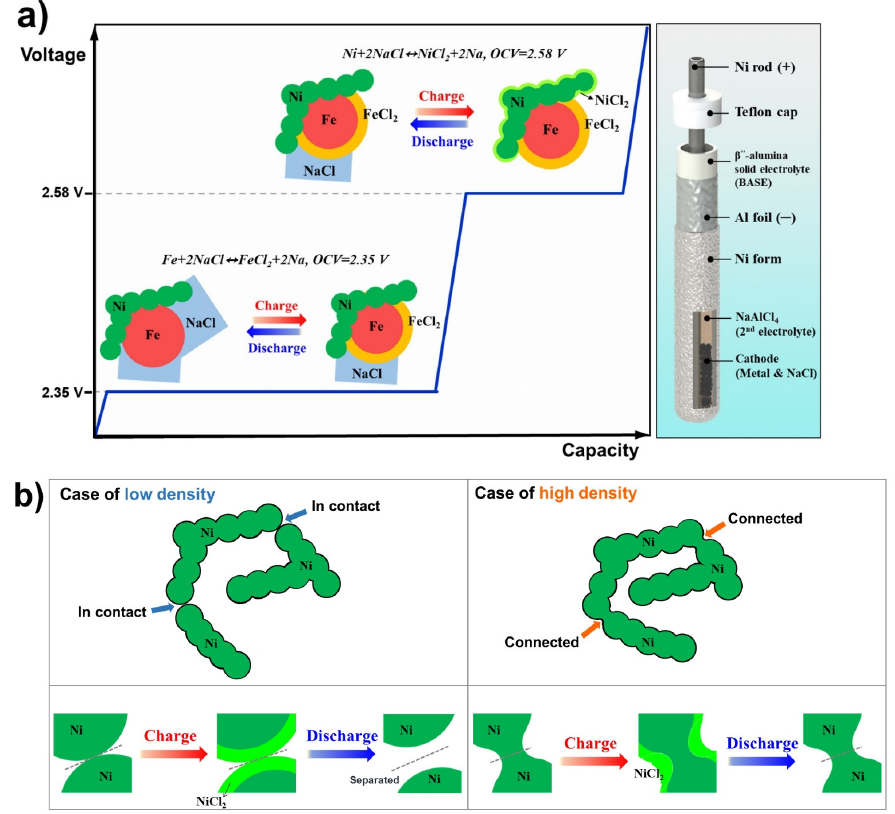
Figure 1. Schematic diagrams. ( a ) charge–discharge mechanism of Na/(Ni,Fe)Cl 2 cell and simple test cell structure; ( b ) difference in the Ni connection shape between low and high densities.